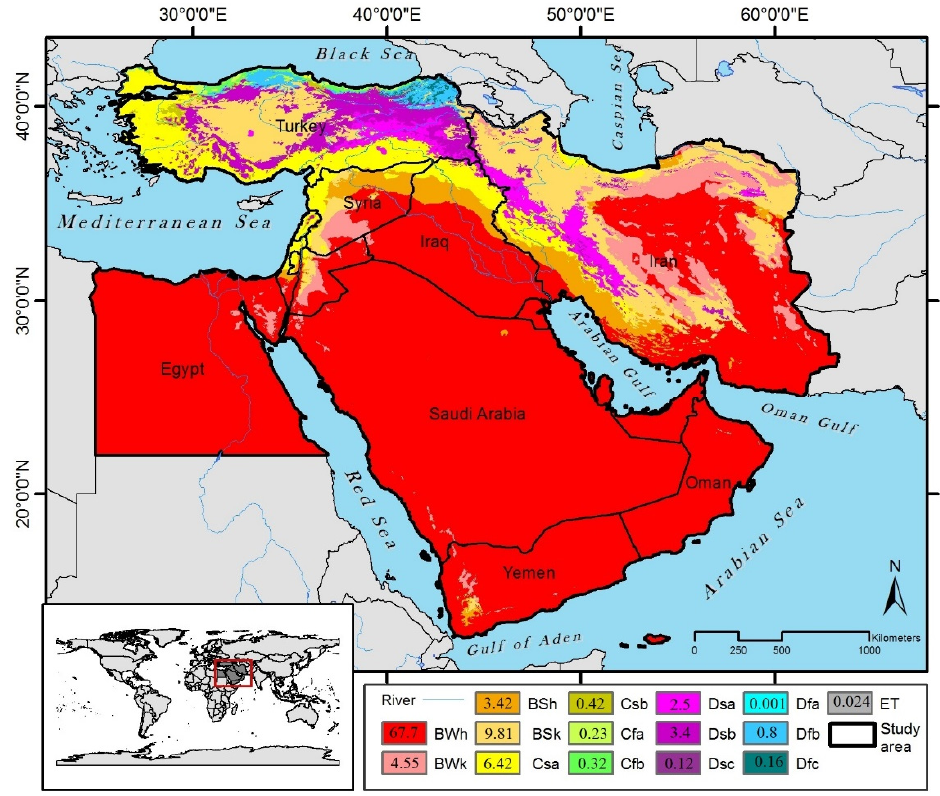
Figure 1. Location of the study area and Köppen–Geiger classification-based climate patterns [51].